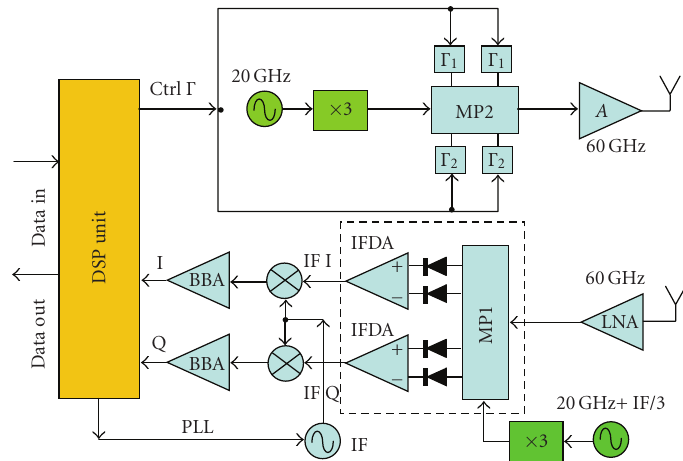
Figure 6: The simplified block diagram of a multiport heterodyne transceiver.